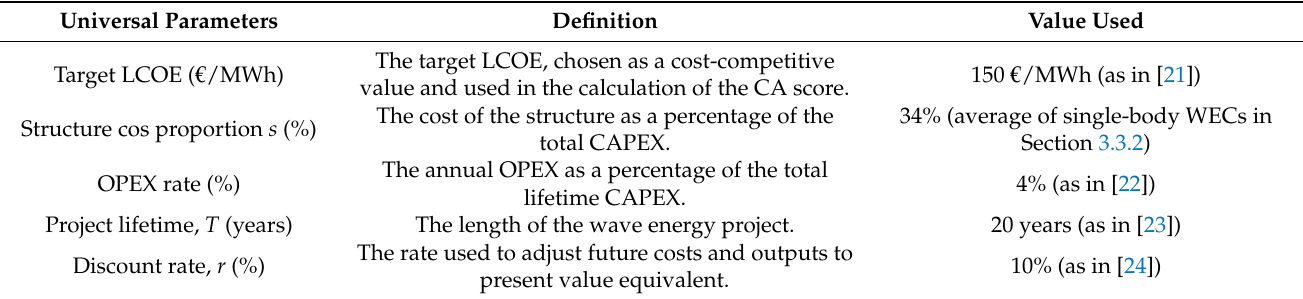
Table 4. Universal input parameters and their